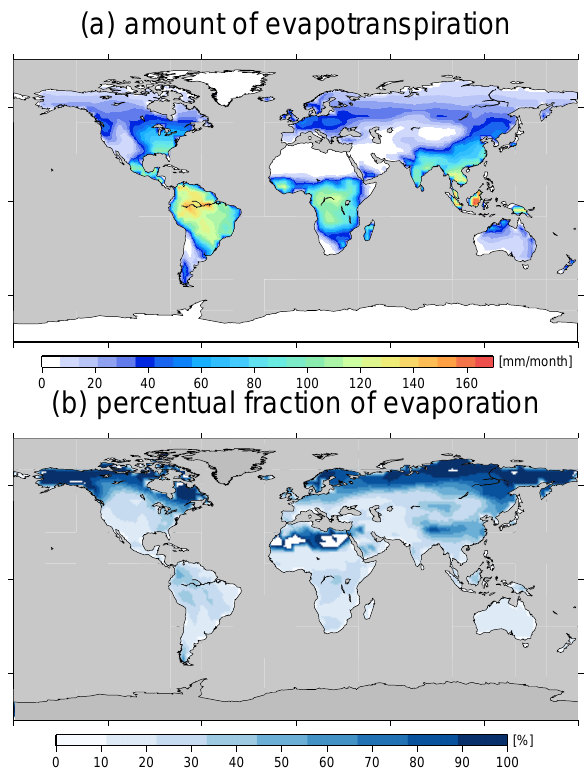
Fig. 7. Panel (a) shows the annual mean amount of evapotranspiration from land surface, and (b) the fraction of evaporation expressed as percentual amount of total evapotranspiration.